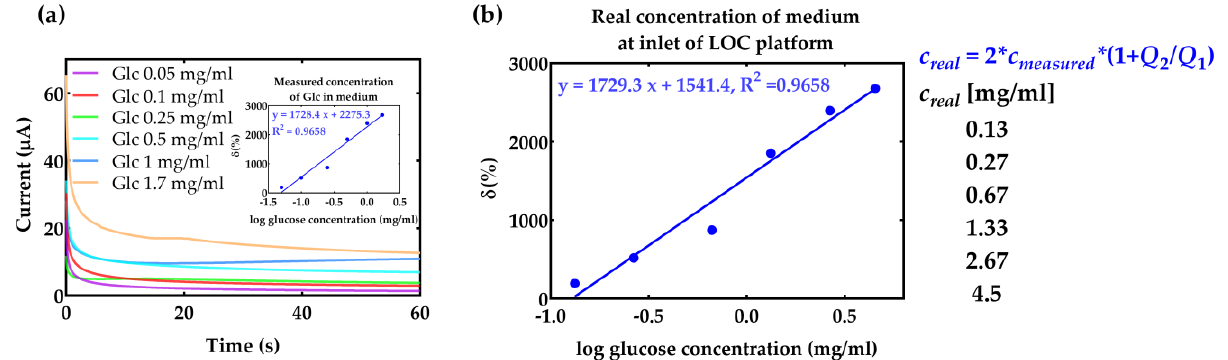
Figure 5. ( a ) Results of chronoamperometry for different concentrations of Glc in cell medium Inset: Calibration curve of Glc detection for medium diluted with acetic acid and enzyme. ( b ) Calibration curve of Glc detection in the cell medium for Glc concentrations at inlet of LOC. The real concentration is calculated by multiplying the measured concentration with the flow rate factor and factor 2 which presents dilution with enzyme mixing. The signal is presented as a relative change versus acetate buffer response: 𝛿(%) = 100 × (𝐼 𝑐𝑐 − 𝐼 𝑏𝑢𝑓𝑓𝑒𝑟 ) 𝐼 𝑏𝑢𝑓𝑓𝑒𝑟 ⁄ .